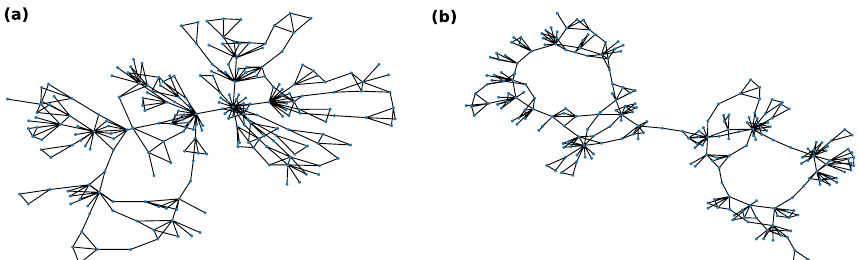
Fig. 8 Illustration of the Repulsion based fractal model for a Y = 0 , b Y = 1 . In both cases, three iteration steps were made, and m = 2 was also fixed